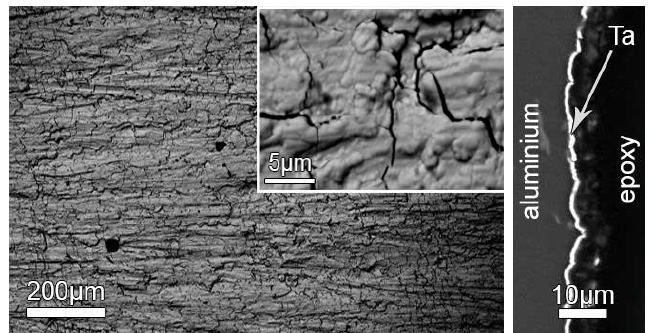
Figure 2. Surface microstructure (200 µ m) and (5 µ m) and view of tantalum coating on a gradient Figure 2. Surface microstructure (200 μm) and (5 μm) and view of tantalum coating on a gradient Figure 2. Surface microstructure (200 μm) and (5 μm) and view of tantalum coating on a gradient Figure 2. Surface microstructure (200 μm) and (5 μm) and view of tantalum coating on a gradient aluminum substrate ( t Cond = 300–350 ◦ C). aluminum substrate ( t Cond = 300–350 °С). aluminum substrate ( t Cond = 300–350 °С). aluminum substrate ( t Cond = 300–350 °С).